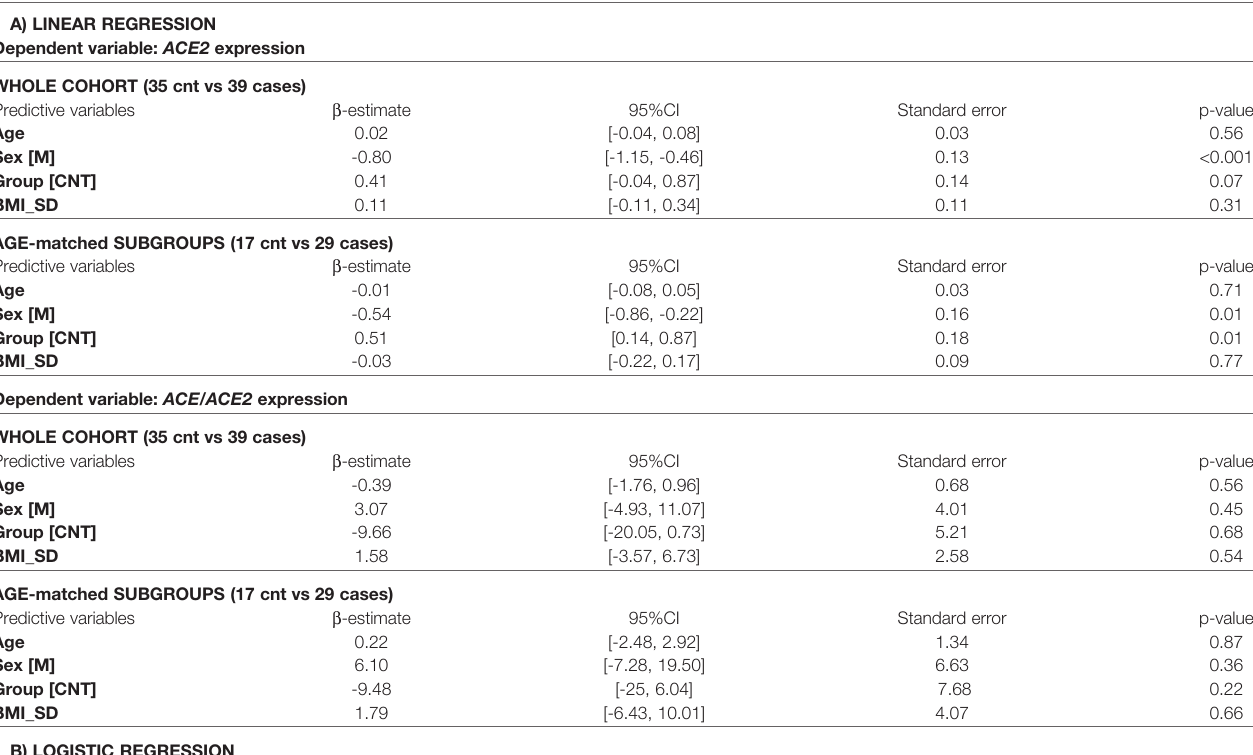
TABLE 3 | Regression